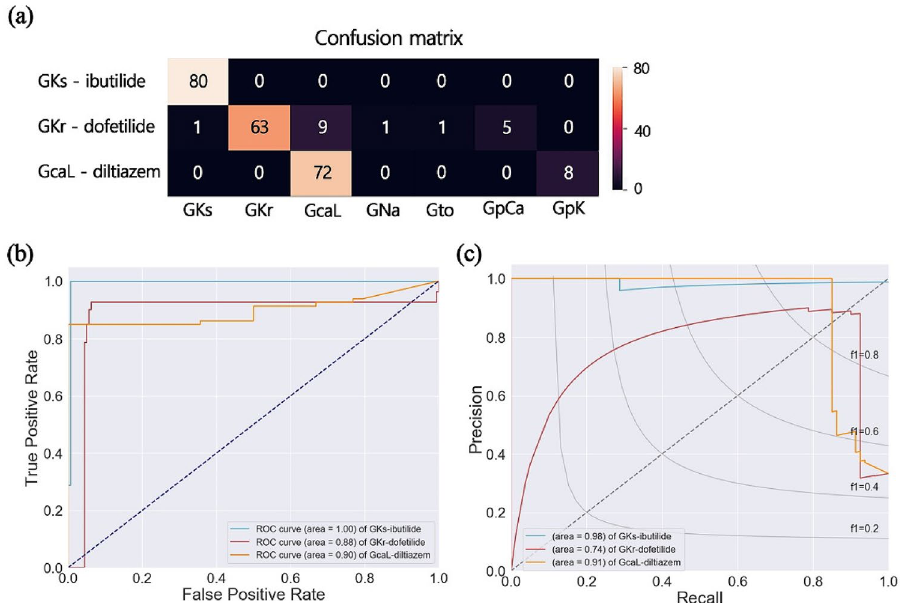
Figure 3. Validation of proposed model using AP shapes with drug effects. Confusion matrix ( a ), ROC curves ( b ), and precision-recall curves ( c ) for predicting the ion channel conductance by drug effects of ibutilide, dofetilide, and